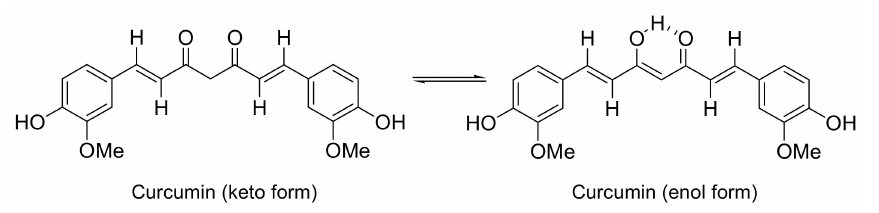
Figure 1. Curcumin presented in its two possible tautomeric